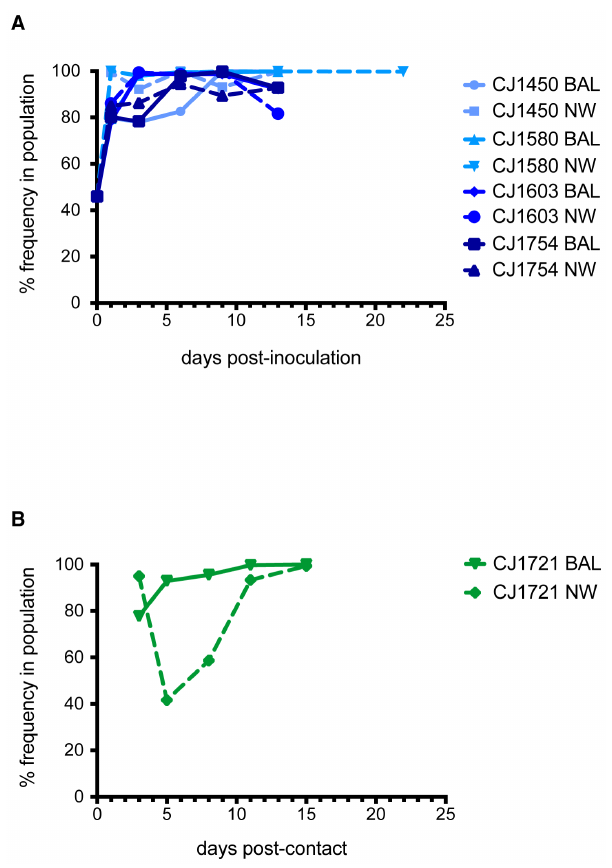
Figure 5. The NP D53E mutation is rapidly fixed in all infected animals. (A) D53E quickly rises in frequency in all index animals. (B) D53E is transmitted to CJ1721. Frequencies in the upper and lower respiratory tracts in CJ1721 right after transmission closely